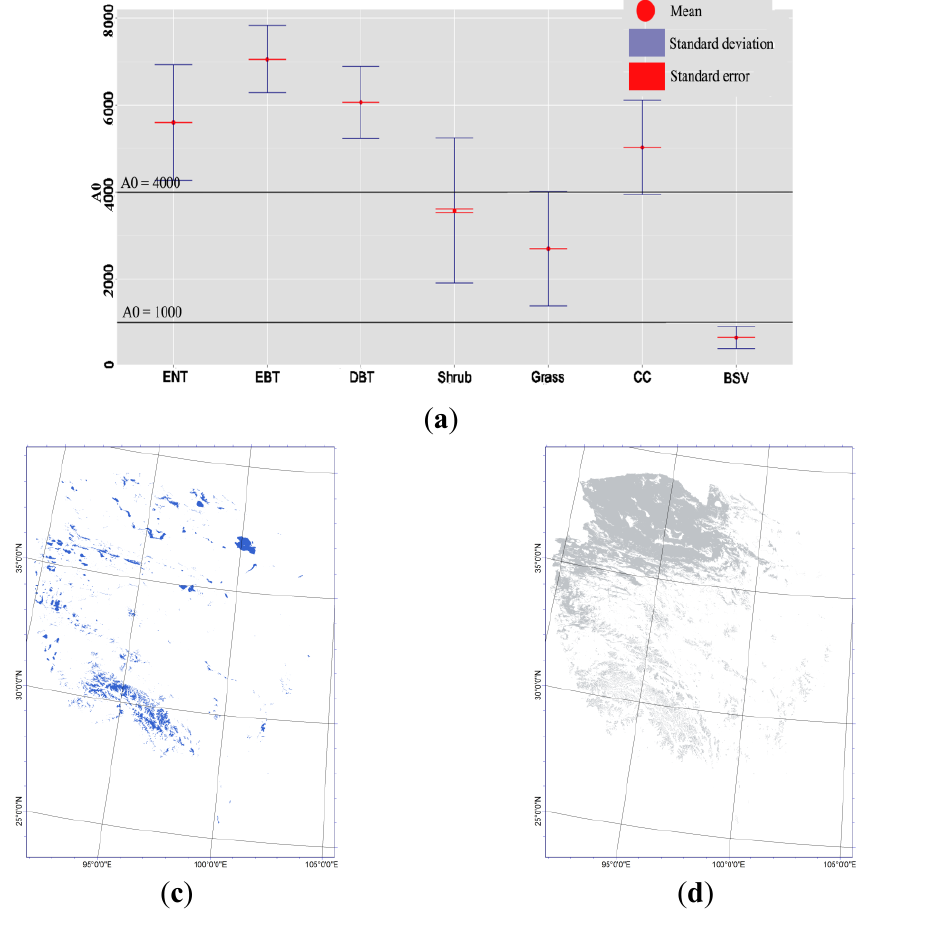
Figure 2. Spatial partitioning (first level of hierarchical soft time-space classification): ( a ) illustration of the mean standard deviation and standard error of amplitude A for each PFT; ( b ) four broad mapping categories segmented by amplitude thresholds A 0 non-vegetation; ( d ) category2 with barren or sparsely vegetated; ( e ) category3 includes shrub or grass; ( f ) category4 includes the remaining five types. Vegetation types represented by initials: evergreen needle leaf trees (ENT), evergreen broad leaf trees (EBT), deciduous needle leaf trees (DNT), deciduous broad leaf trees (DBT), crop (CC), barren or sparse vegetation